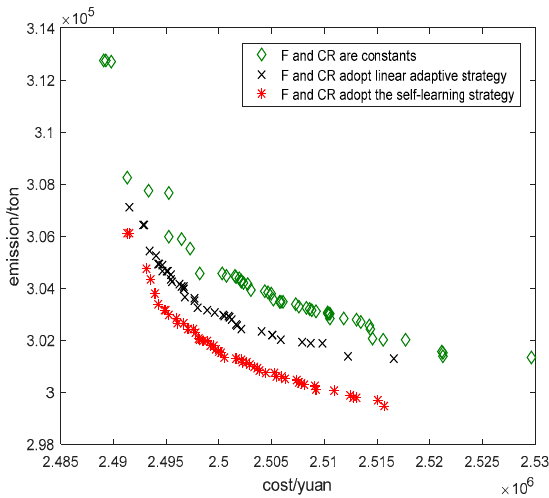
Figure 4. Comparison of results of different parameters.